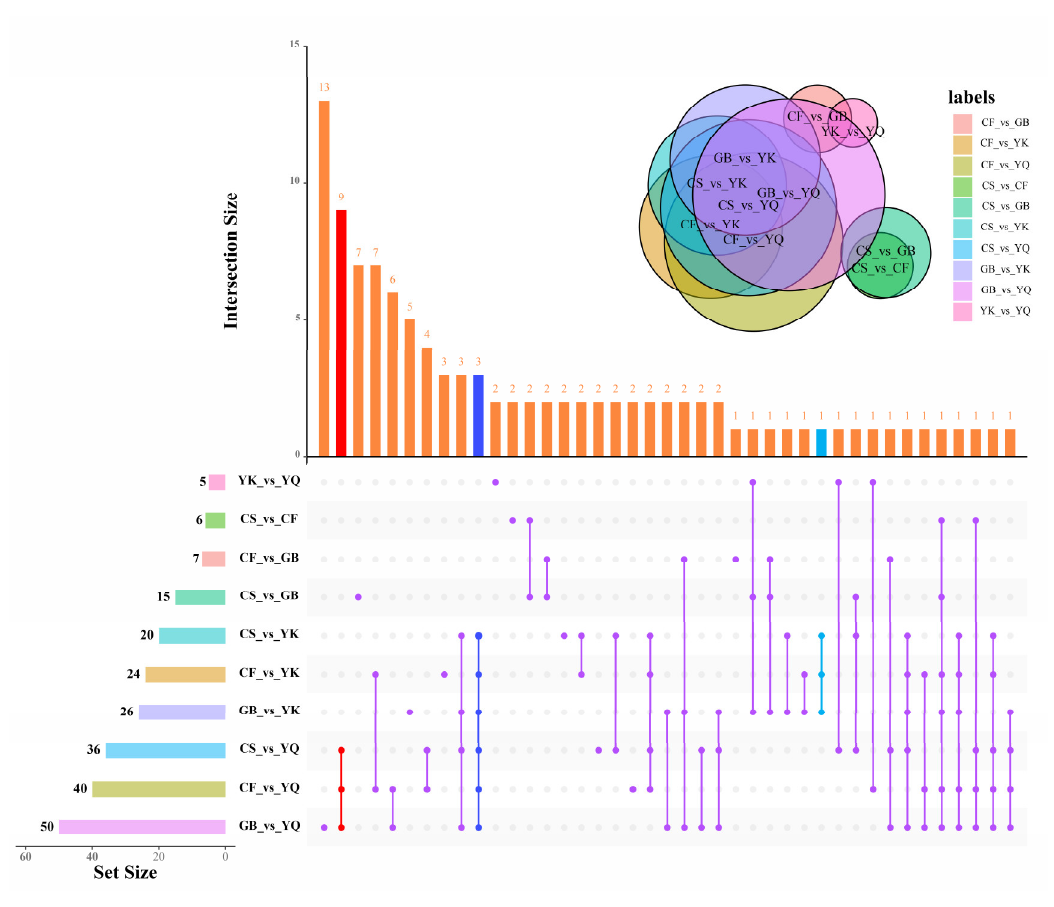
Figure 5. Upset plot of differentially accumulated phenolic metabolites of FDRs from different origins. Venn diagram and upset plot show sets and intersections of different comparison groups of FDRs. Refer to Tong, B. et al. [21] for legend description.